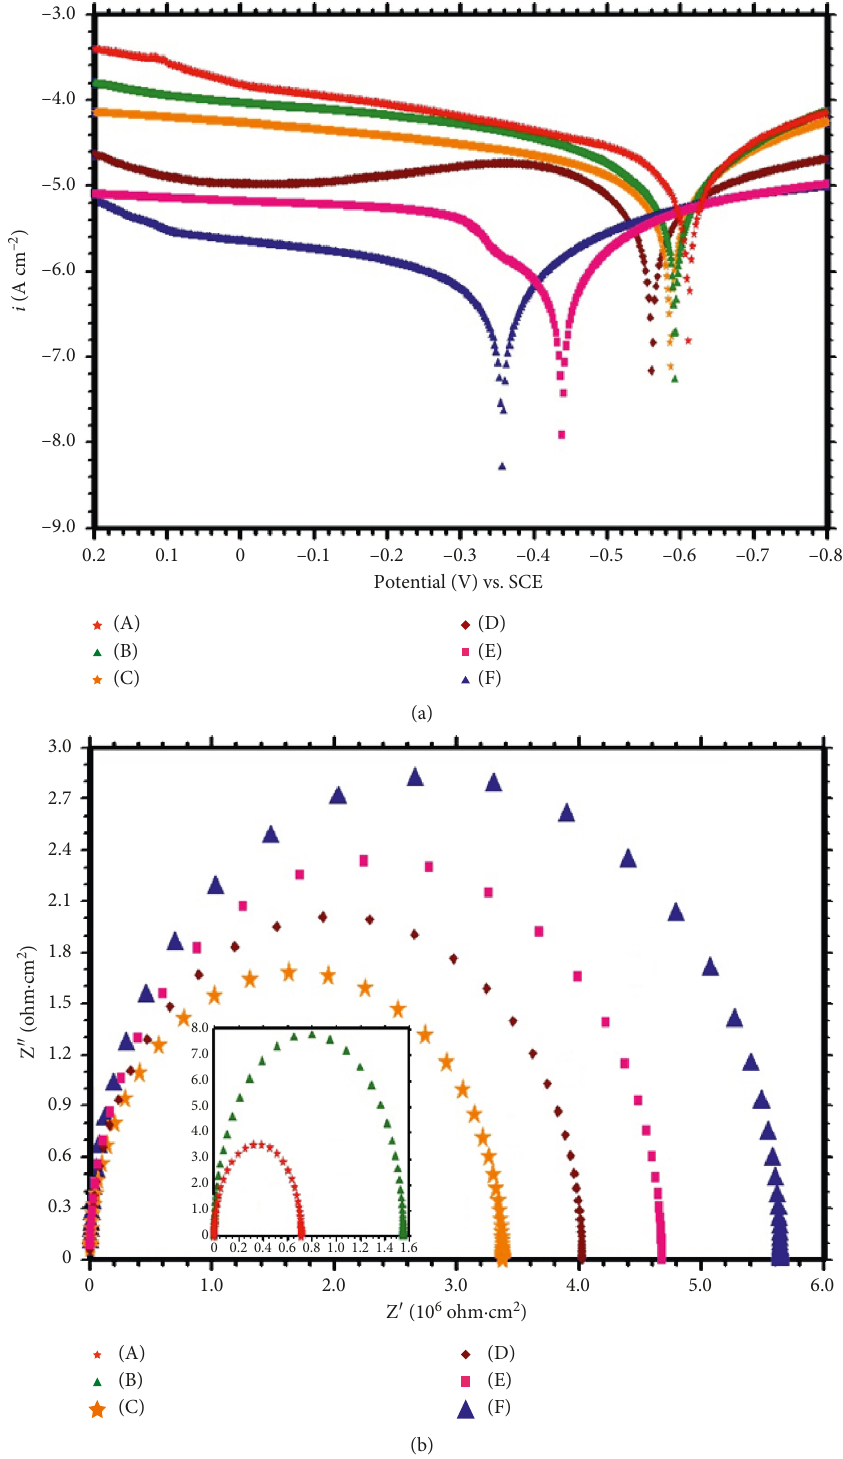
Figure 4: Potentiodynamic polarization (a) and Nyquist curves (b). (A) Uncoated Ti6Al4V alloy. (B) Anodized Ti6Al4V alloy. (C) MHA coated on Ti6Al4V alloy. (D) CS-MHA coated on Ti6Al4V alloy. (E) HTN-MHA coated on Ti6Al4V alloy. (F) HTN-CS-MHA composite coated on Ti6Al4V alloy in SBF